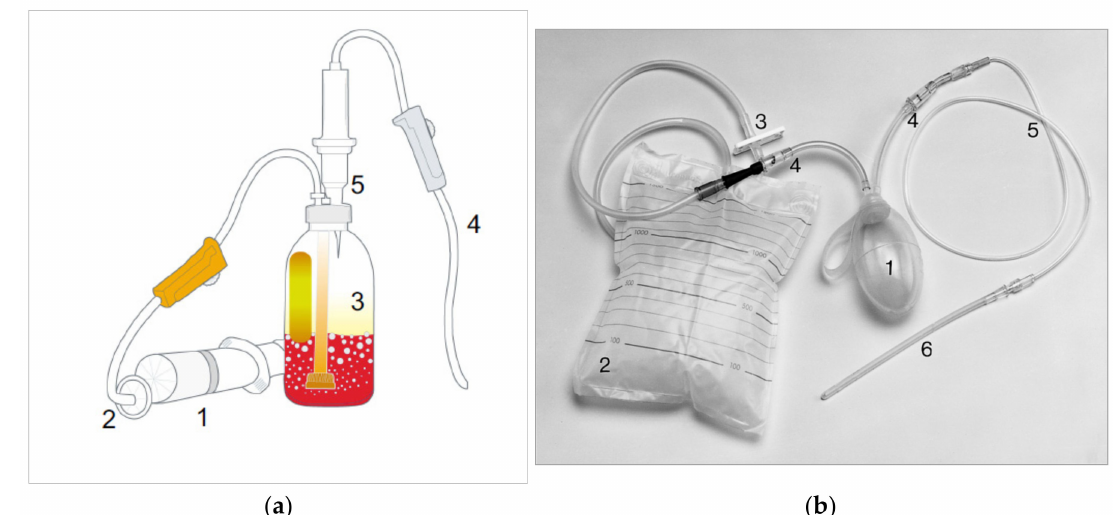
Figure 2. ( a ) [9] Major autohemotherapy. Standardized system acc. to the Medical Device Directives MDD 93/42EC. 1. Ozone syringe (PP, siliconized). 2. Bacterial filter 0,2 µ (germstop). 3. Vacuum bottle (glass) with micro bubble system (PP) 4. Transfusion set (PE). 5. Latex-free plug. ( b ) [9] Set for rectal insufflation, standardized system acc. to the Medical Device Directives 93/42 EC. 1. Dosage pump (silicone). 2. storage bag. 3. Clamp. 4. one-way valve. 5. connection line (PE). 6. catheter (PE). Table 1. Indications of the systemic ozone treatments MAH and RI and the underlying mechanisms of action acc. to [9]. Applications Indications Mechanims of Action Systemic